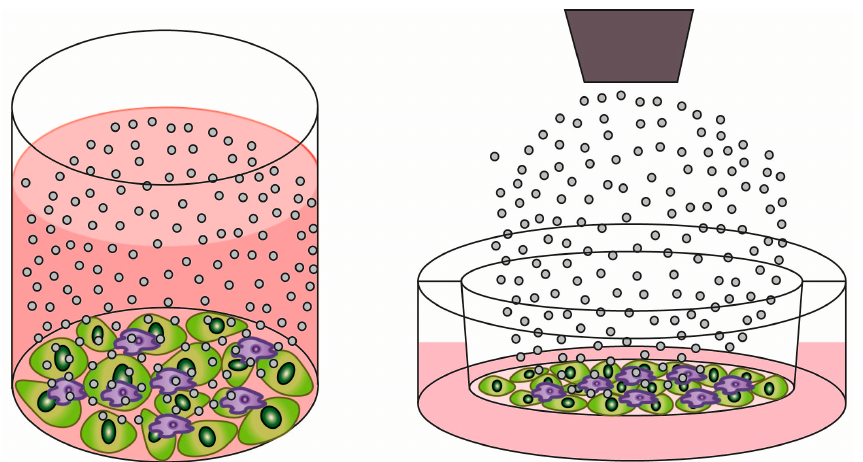
Figure 4. Submerged ( left ) and ALI exposures ( right ) to NMs. Submerged exposures are considered easier, whereas ALI exposures are considered more physiologically relevant for inhalation (and dermal and intestinal) exposures.